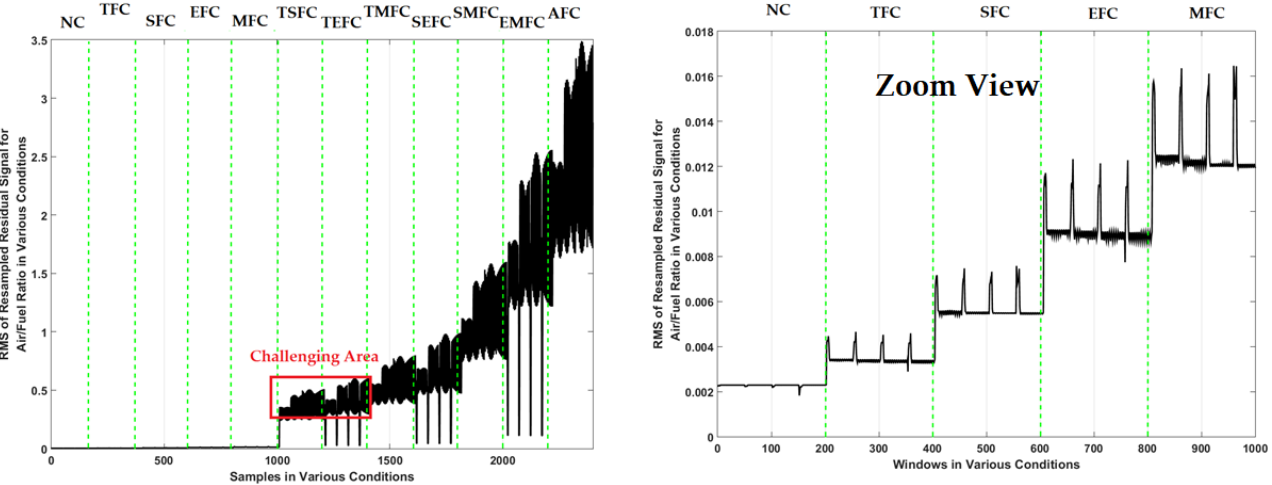
Figure 9. Resampled RMS residual signals for air-to-fuel ratio using the proposed FGAL-FLCR tech- nique.